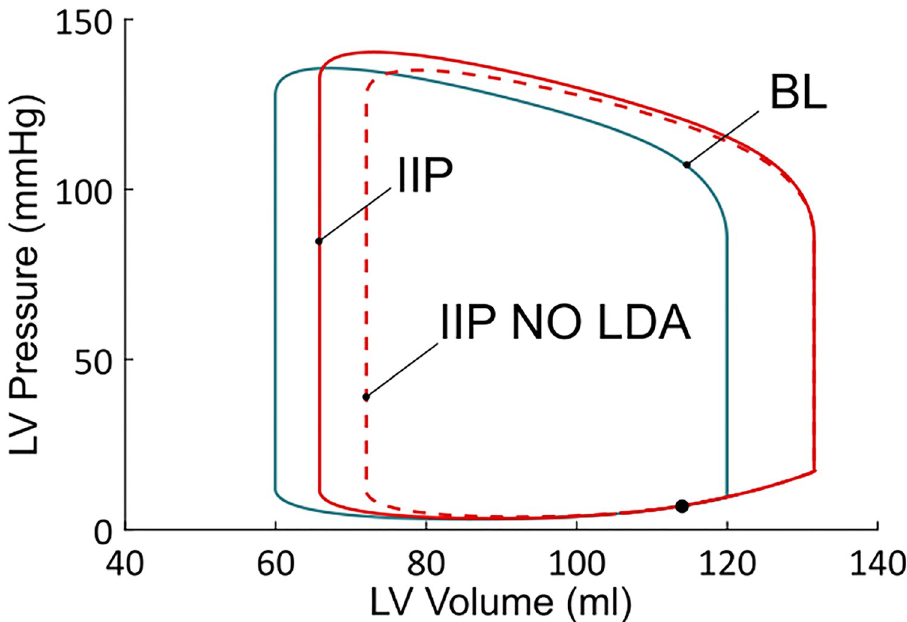
Fig 7. Left ventricular PV loops from the BL, IIP and IIP NO LDA simulations. IIP starts during ventricular filling (black dot). PV loop for the baseline case (blue) corresponds to a stabilized behavior (each heartbeat leads to that same PV loop). On the other hand, the two PV loops for the IIP protocols (red dashed or solid lines) correspond to a transient response to a preload change. The behavior is not stabilized yet, as this would take several more heartbeats to return to the baseline state. Those PV loops are thus not closed, but this it cannot be seen in the picture.